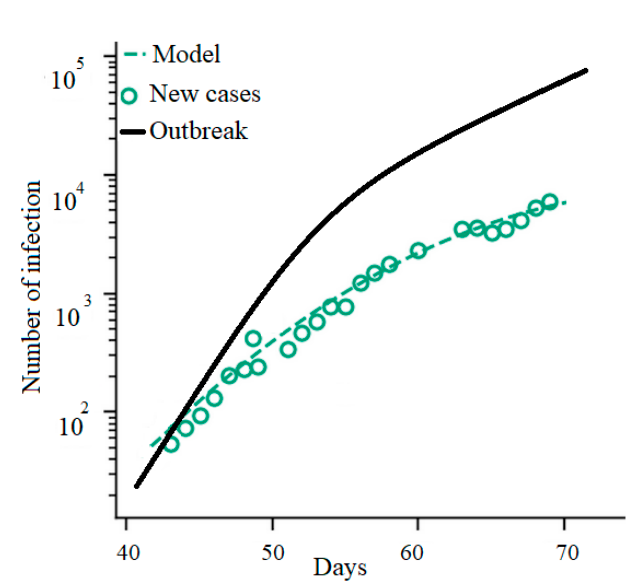
Figure 1. Italy’s COVID-19 outbreak: the actual number of confirmed infections vs. epidemiological